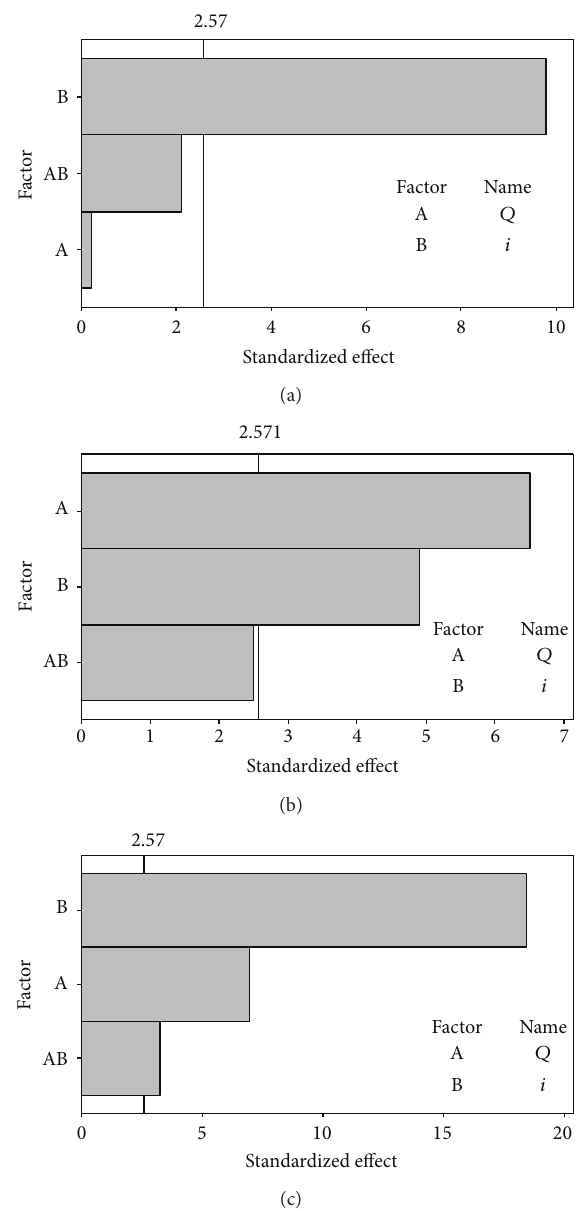
Figure 6: Pareto diagrams of effects for the response: (a) 𝑈 , (b) 𝑡 , and (c) 𝐸 , with a 95% confidence interval ( 𝛼 = 0.05